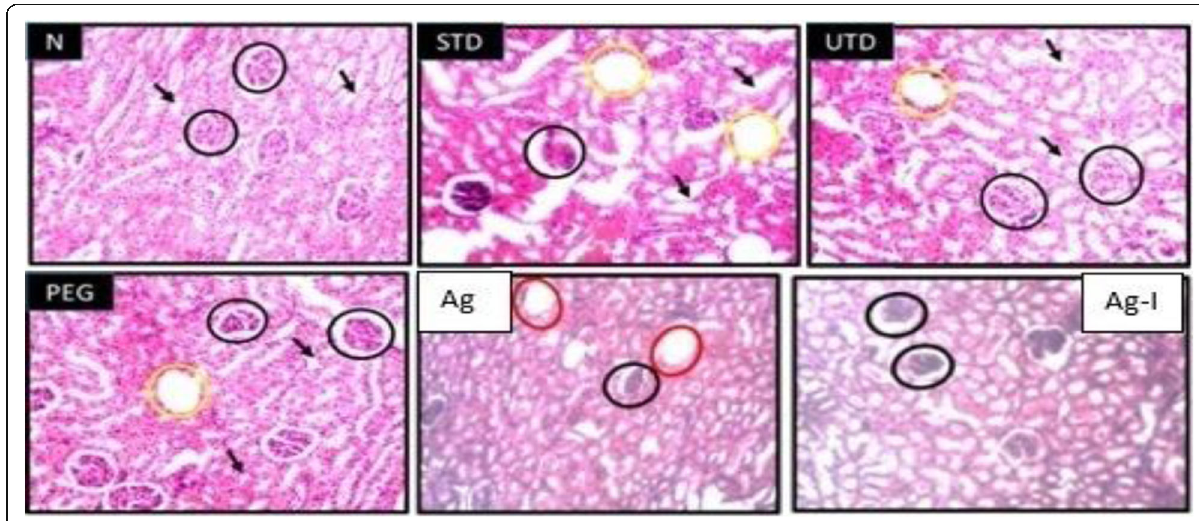
Fig. 2 Effect of PEG, Ag-NP and Ag-I NP treatment on histological sections of kidney in excision wound inflected albino rats. Hematoxylin and eosin stain at × 100 and × 400